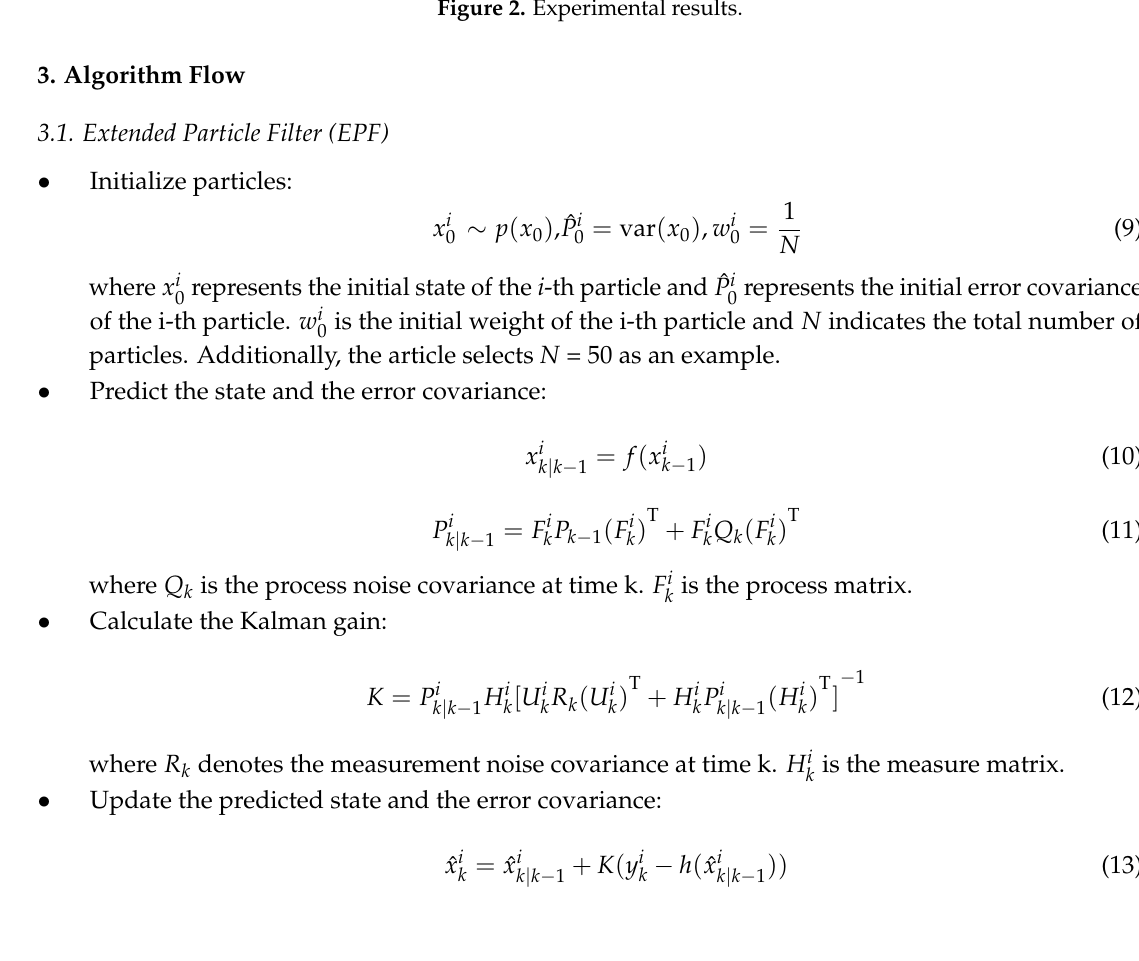
Figure 2. Experimental results.